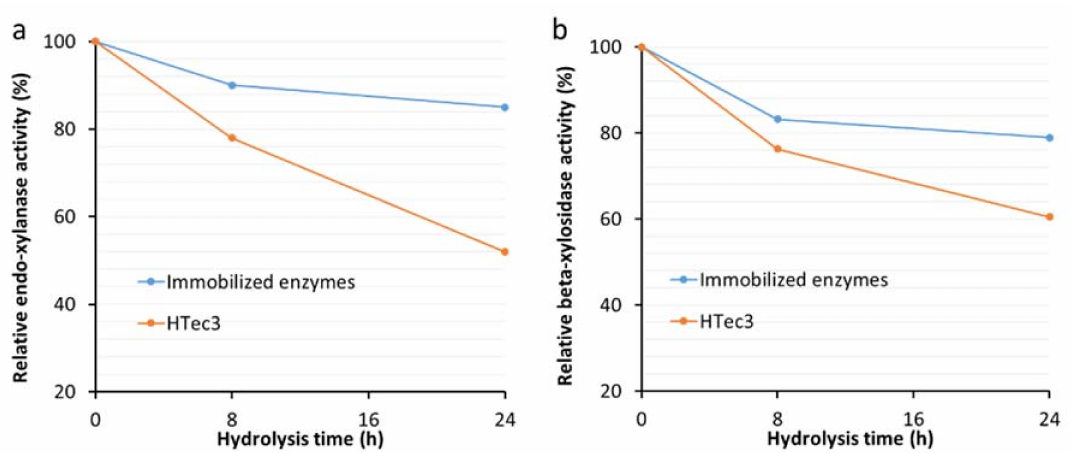
Figure 3. Relative endo-xylanase ( a ) and beta-xylosidase ( b ) activities of immobilized HTec3 xylanases and non-immobilized HTec3 xylanases over 24 h.